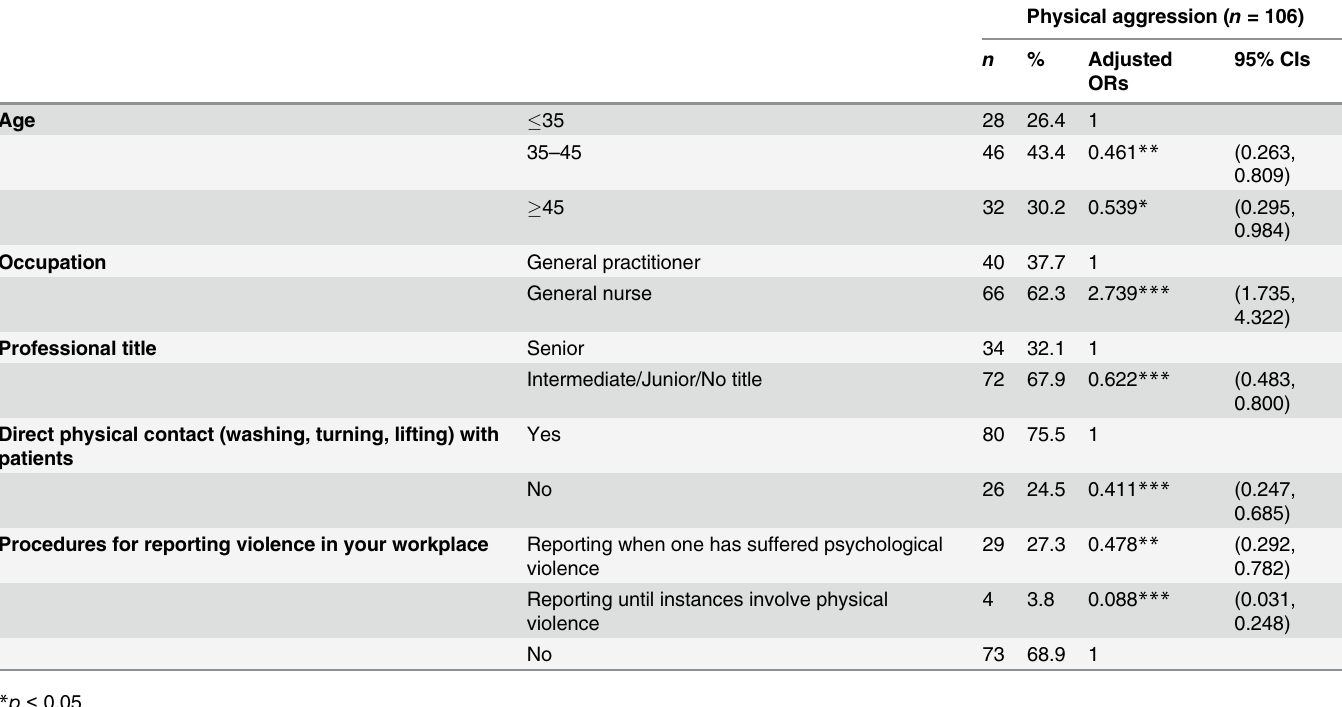
Table 5. Risk factors associated with physical violence among general practitioners and general nurses in township hospitals in Heilongjiang province; binary logistic regression model